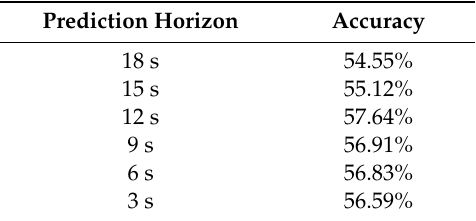
Table 2. Prediction accuracy of BP neural network.